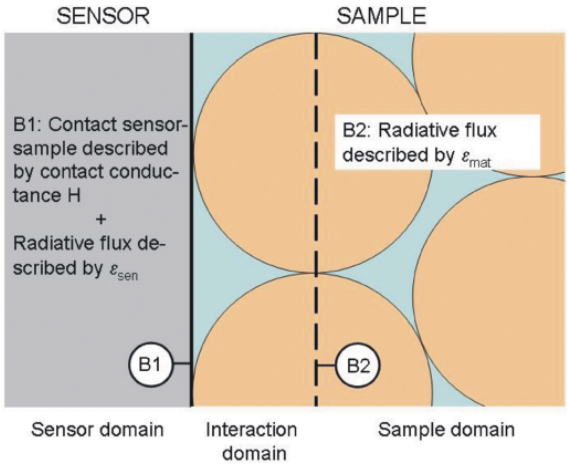
Fig. 7. Schematic of the heat transfer mechanisms between sensor and sample.